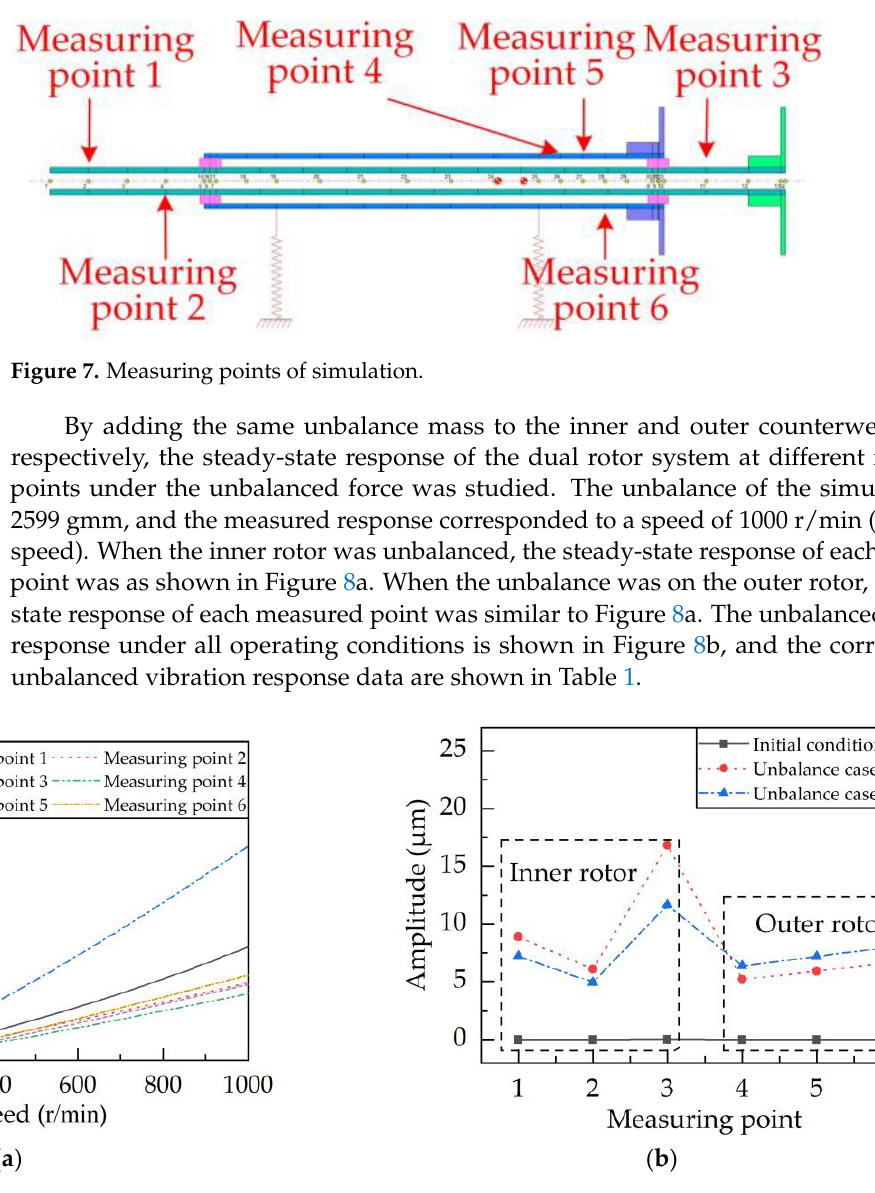
Figure 8. The steady-state response. ( a ) The unbalance is on the inner rotor; ( b ) unbalanced vibration response of all measuring points.